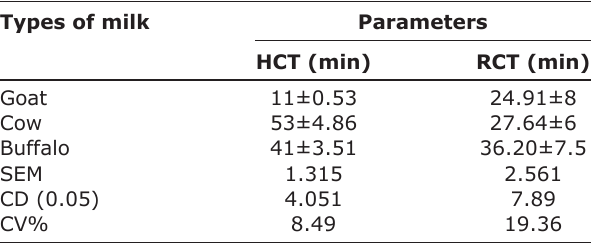
Table-2: Selected processing-related parameters (HCT and RCT) of goat, cow and buffalo milk.